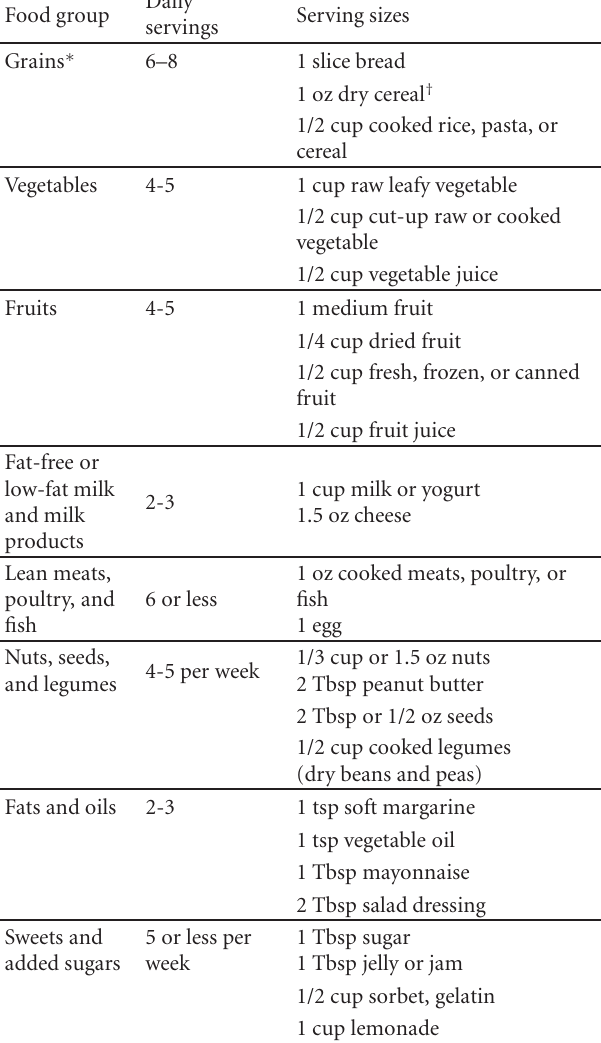
Table 3: Dash eating